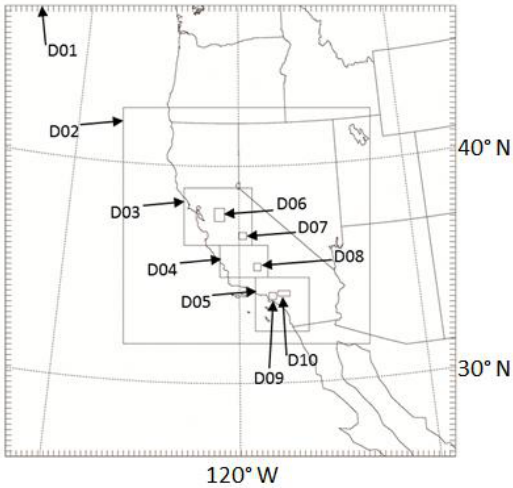
Figure 1. Modeling domains configuration: domain D01: 27-km resolution; D02: 9 km; D03–D05: 3 km; D06 through D10: 1 km. Domain D02 is centered on California and domains D03–D10 are positioned over various parts of the state.